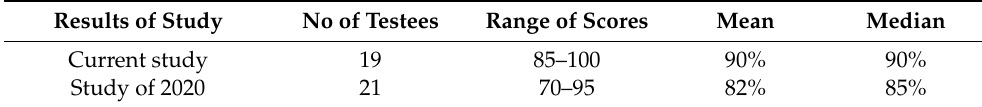
Table 3. Comparison of exit test scores in the current and prior studies.